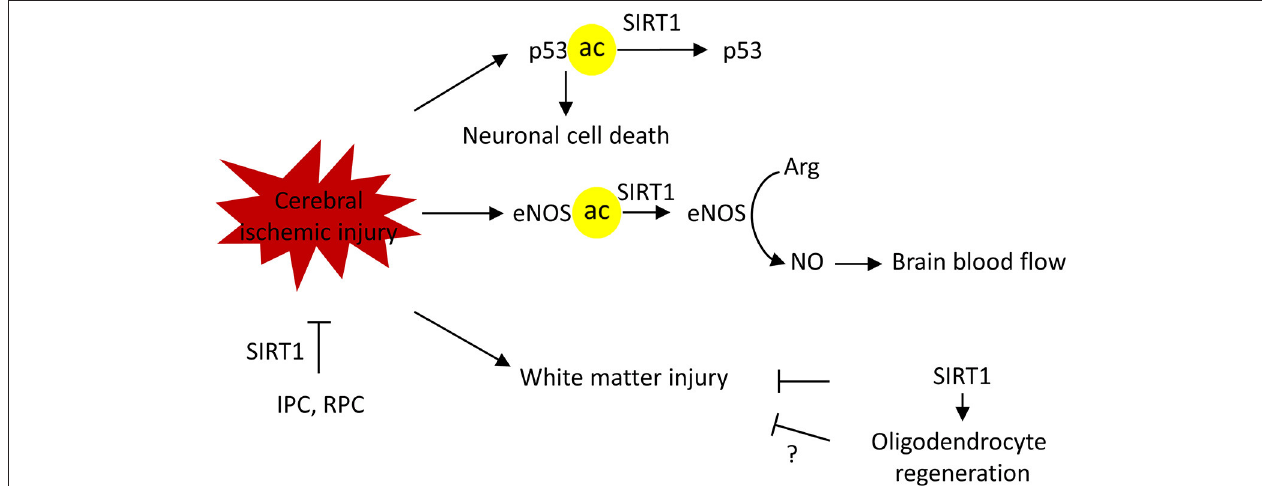
FIGURE 6 | SIRT1 protects against cerebral ischemic injury in multiple mechanisms. SIRT1 deacetylate p53 to block the p53-induced apoptotic pathway, thus, promoting neuronal survival. SIRT1 deacetylates endothelial nitric oxide synthase (eNOS) to regulate vascular tone and maintain brain blood flow. SIRT1protects against white matter injury in ischemic injury, possible via promoting the oligodendrocyte regeneration. Finally, SIRT1 is required for ischemic preconditioning (IPC) and resveratrol preconditioning (RPC) induced ischemic neuroprotection. Arg, L-arginine, NO, nitric